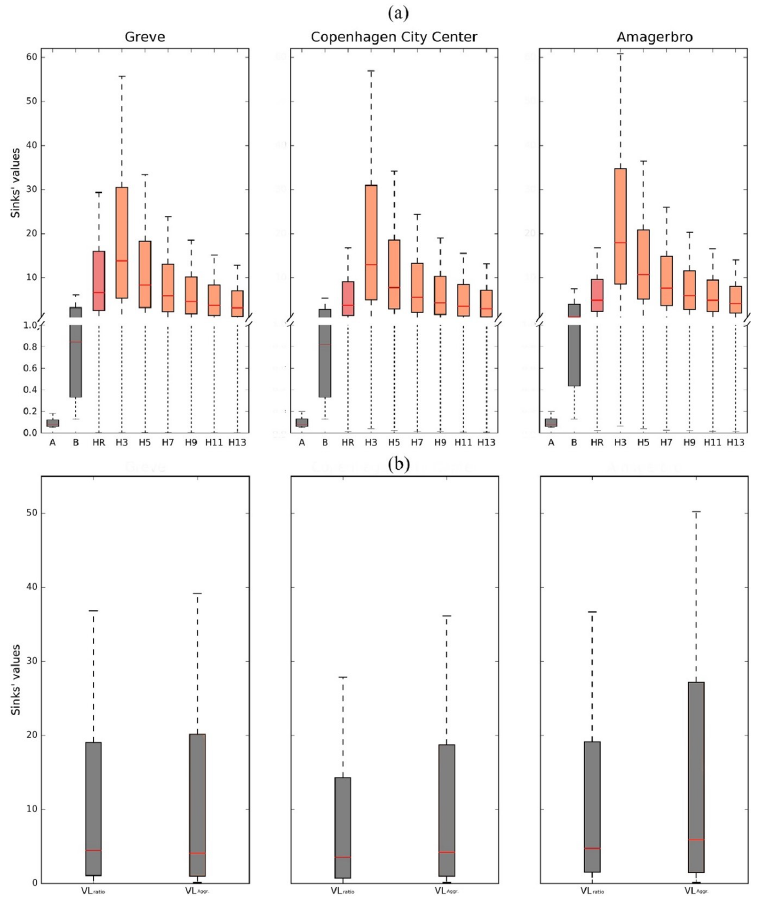
Figure A2. ( a ) Boxplots of maximum depth, volume and HVR ratio , where iteration ranges were determined for three case areas. ( b ) Boxplots of VL ratio and VL Aggr ( VL source ) when HVR ratio of 15% was used, where iteration ranges of VL ratio were determined for three case areas. Note: A = maximum depth; B = volume; HR = HVR Radar ; H3 = HVR 30 mm ; H5 = HVR 50 mm ; H7 = HVR 70 mm ; H9 = ratio ratio ratio ratio HVR 90 mm ; H11 = HVR 110 mm ; H13 = HVR 130 mm ratio ratio ratio